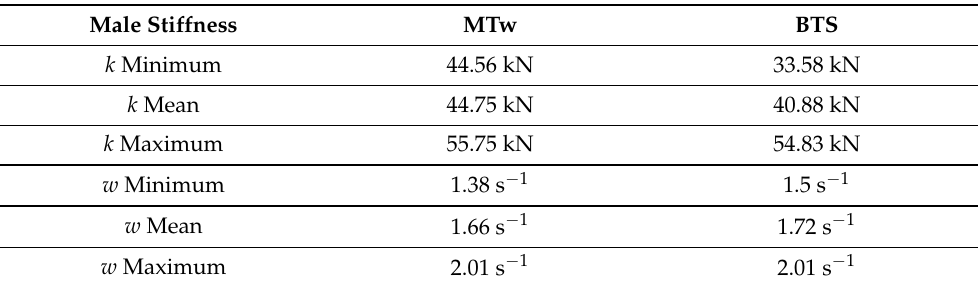
Table 4. Data obtained from the muscle stiffness test, using the MTw and BTS